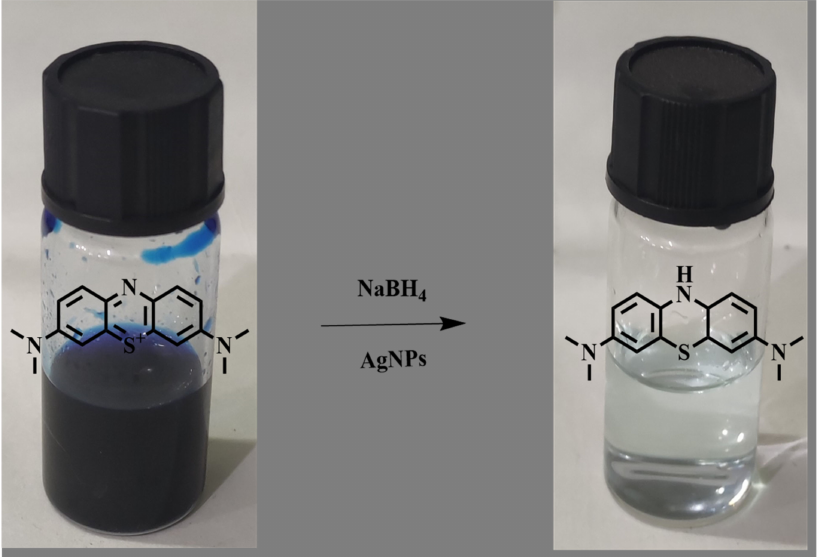
Figure 12. Possible mechanism of degradation of Methylene